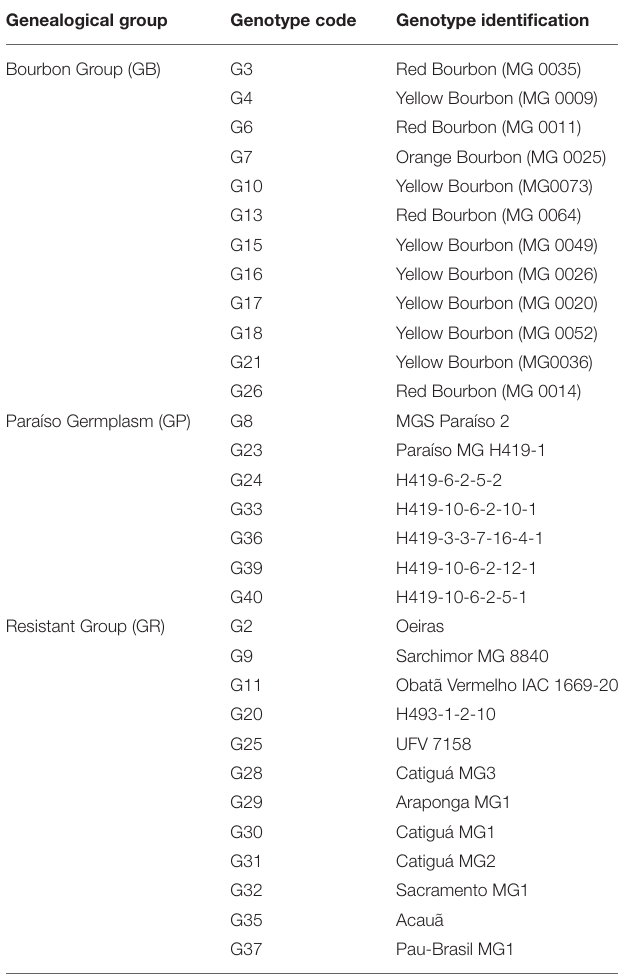
TABLE 1 | Coding and identification of the C. arabica L. elite genotypes evaluated. Genealogical